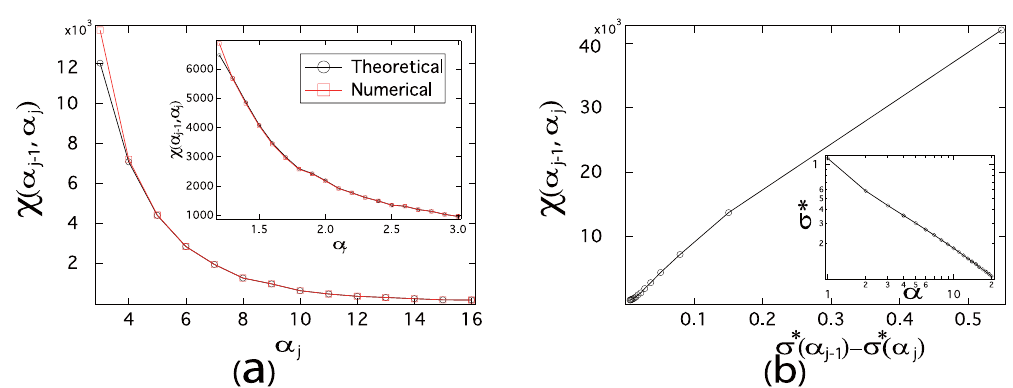
Figure 6. ( a ) The number χ ( α j − 1 , α j ) of crossings as a function of the normalized effective infection rate α j . ( b ) Main figure: the number χ ( α j − 1 , α j ) of crossings as a function of the difference σ * ( α j − 1 ) − σ * ( α j ) of the normalized standard deviation of the metastable infection probability; Inset: the normalized standard deviation σ * of infection probabilities of all nodes as a function of α . The real-world network – Roget, detailed in Section “Real-world graphs” of the supplementary information, is employed. The meta-stable infection probability v k ∞ is obtained by solving (11), the number χ ( α j − 1 , α j ) of crossings is obtained by (1) and the value of σ * ( α ) is (1) obtained by (7). The NIMFA epidemic threshold τ ≈ . 0 0831 c